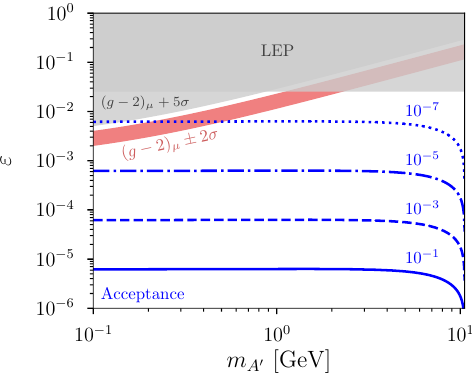
Figure 2 . Sensitivity to the dark photon mass and kinetic mixing, ε , under the assumption that selections with the indicated signal acceptance are background-free and can be discovered with 10 signal events after cuts with L = 50 ab − 1 at Belle II. We also show model-independent limits on the dark photon parameters [32, 88], as well as the band favoured by the ( g − 2)